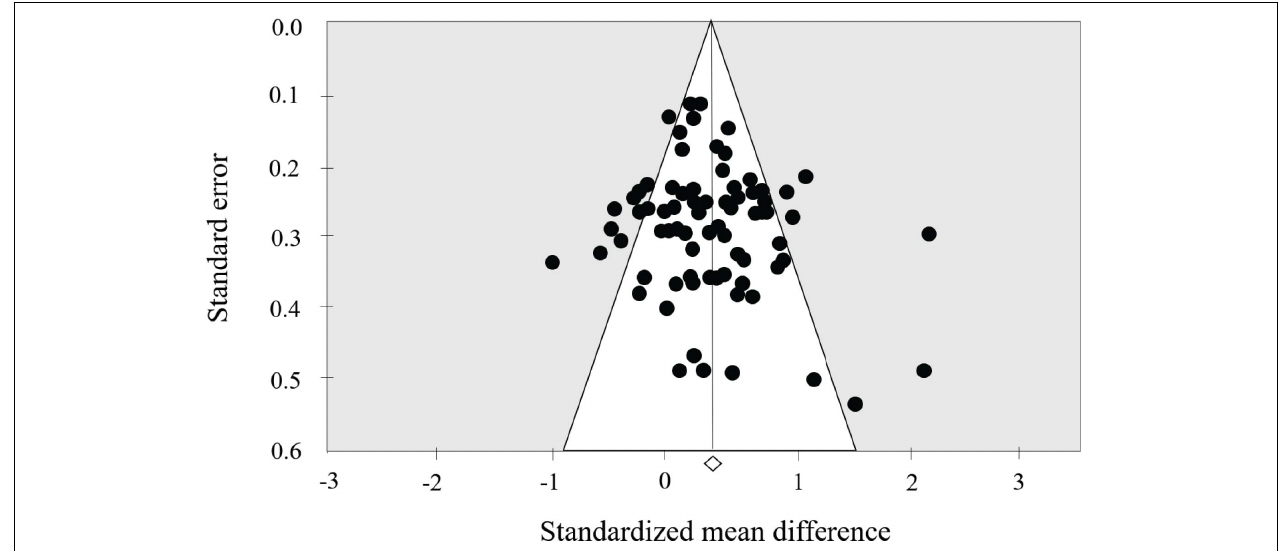
FIGURE 3 | Funnel plot of publication